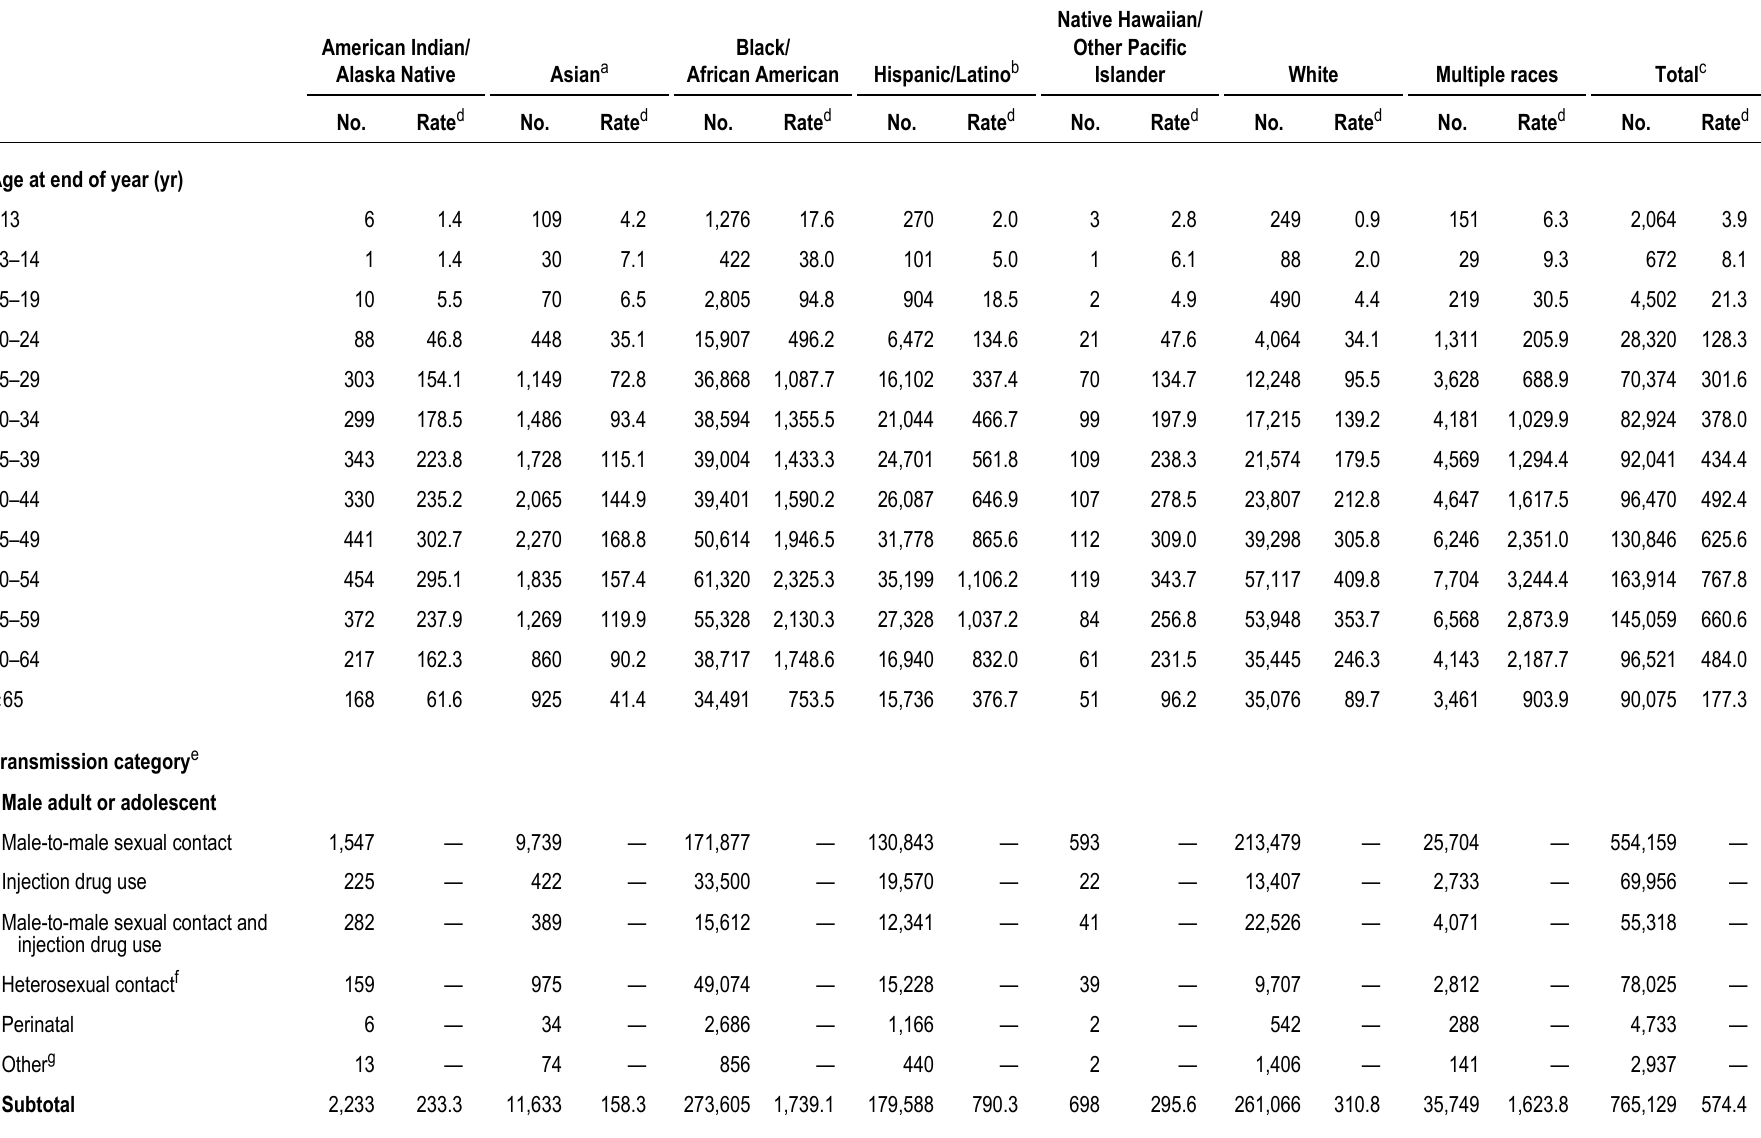
Native Hawaiian/ Black/ Other Pacific African American Hispanic/Latino b Islander White Multiple races Total c